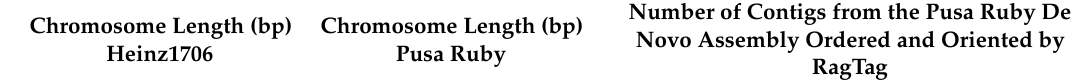
Table 1. Comparison of chromosome length of Heinz1706, which is used as reference genome assembly and Pusa Ruby genome assembled in the current